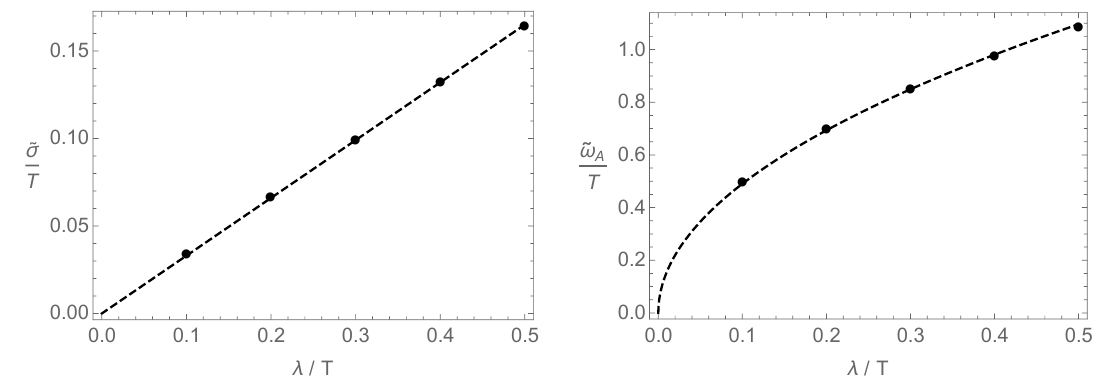
vs. λ . The dashed line is A